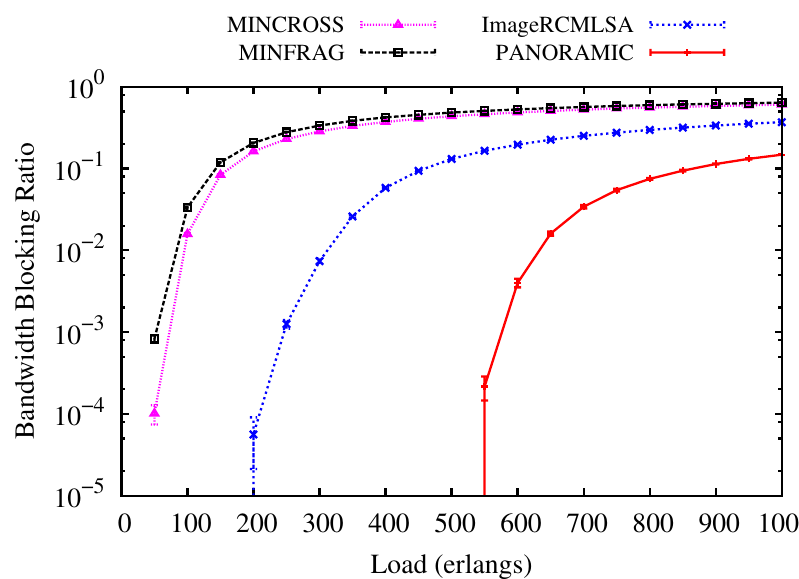
Figure 6. Bandwidth Blocking for NSF topology.